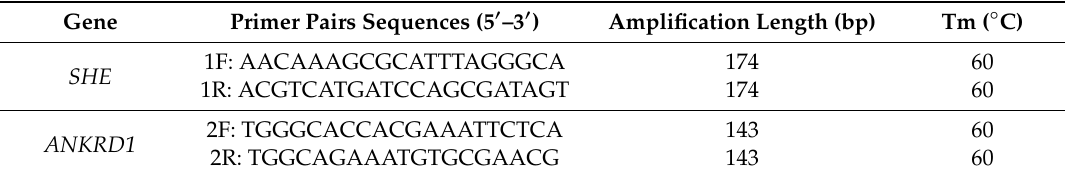
Figure 2. The CNV region of the SHE gene overlaps with the QTL of the sheep. Table 1. The primer information used in this study.